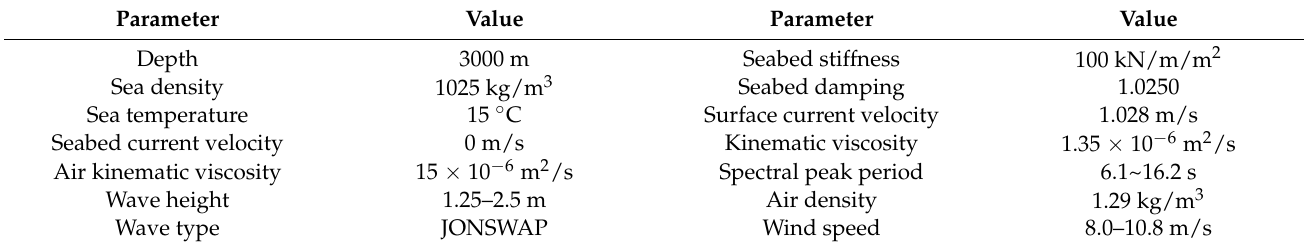
Table 2. Marine environmental parameters.